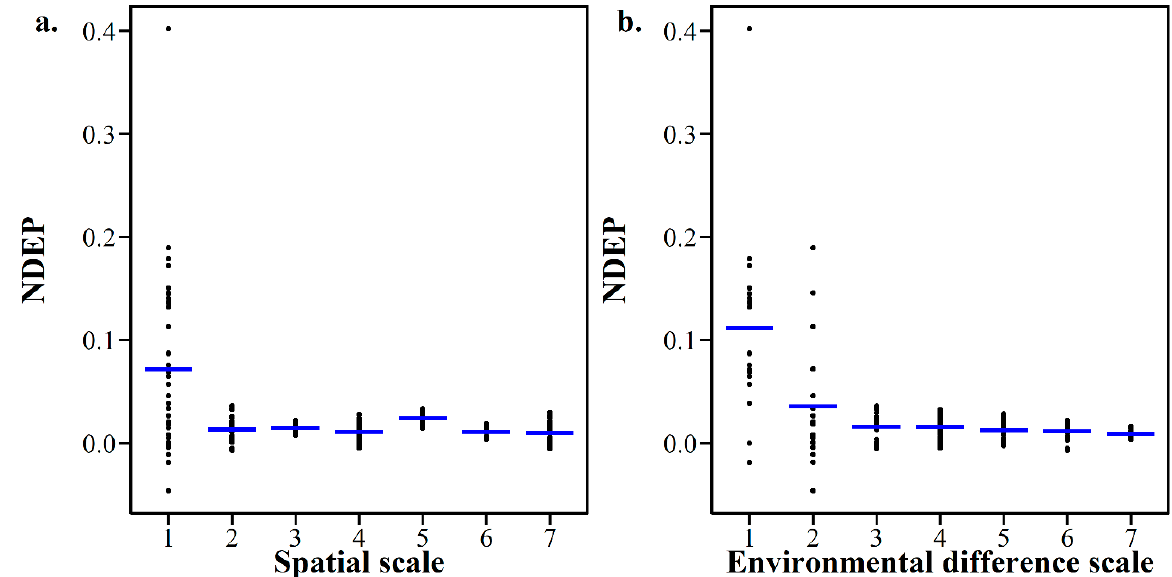
Figure 4. NDEP varies with spatial scale ( a ) and environmental difference scale ( b ). The blue line in the box represents the median value. Table 1. Variation in NDEP values at different spatial scales and environmental difference